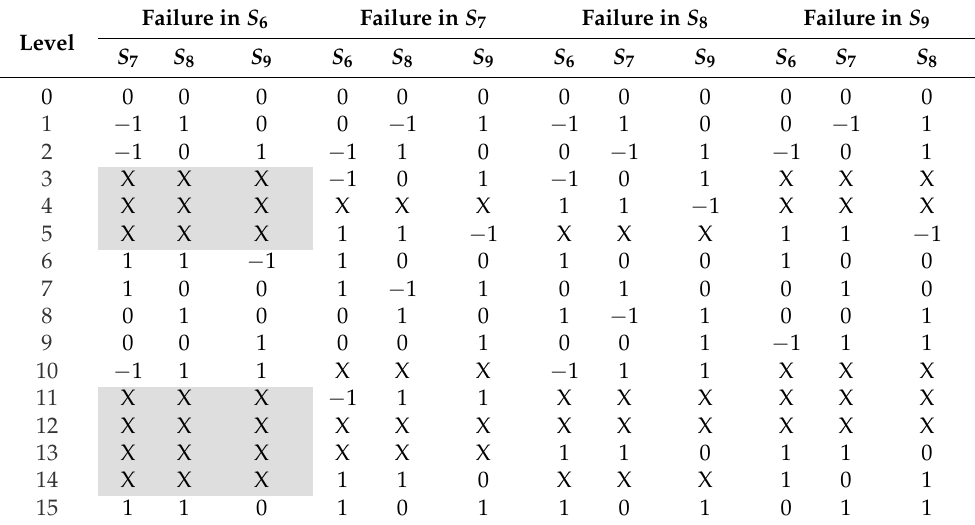
Table 2. Switching patterns to produce the output voltage levels in the event of a failure in one of the inverter